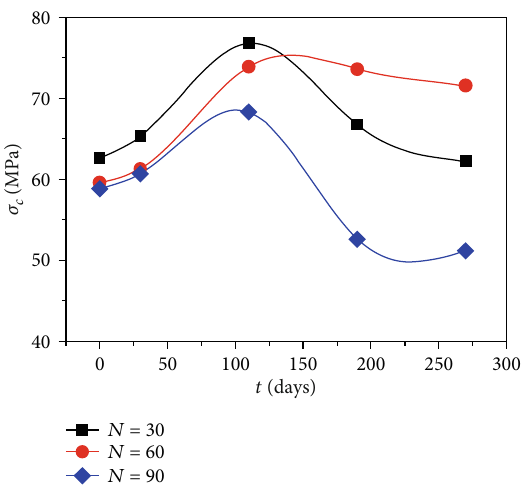
Figure 1: The variation curves of concrete compressive strength and corrosion time under di ff erent freeze-thaw cycles.